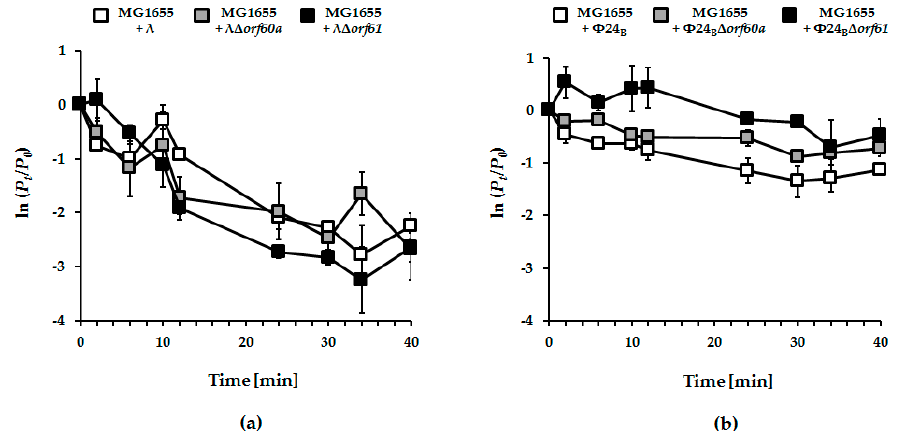
Figure 7. Kinetics of adsorption of lambdoid bacteriophages: λ (panel ( a ); white squares), Φ 24 B (panel ( b ); white squares) and their mutants bearing deletions of orf60a (panels ( a ) and ( b ); grey squares) or orf61 (panels ( a ) and ( b ); black squares) on E. coli MG1655 host. Tested bacteriophages were added to bacterial cell suspension to m.o.i. of 0.1. Ratios of unadsorbed bacteriophages were logarithmically transformed according to the ln ( P t / P 0 ) equation, where P t and P 0 are phage concentrations at tested times and time zero, respectively. The presented results are mean values from three biological experiments with S.D. indicated by error bars.